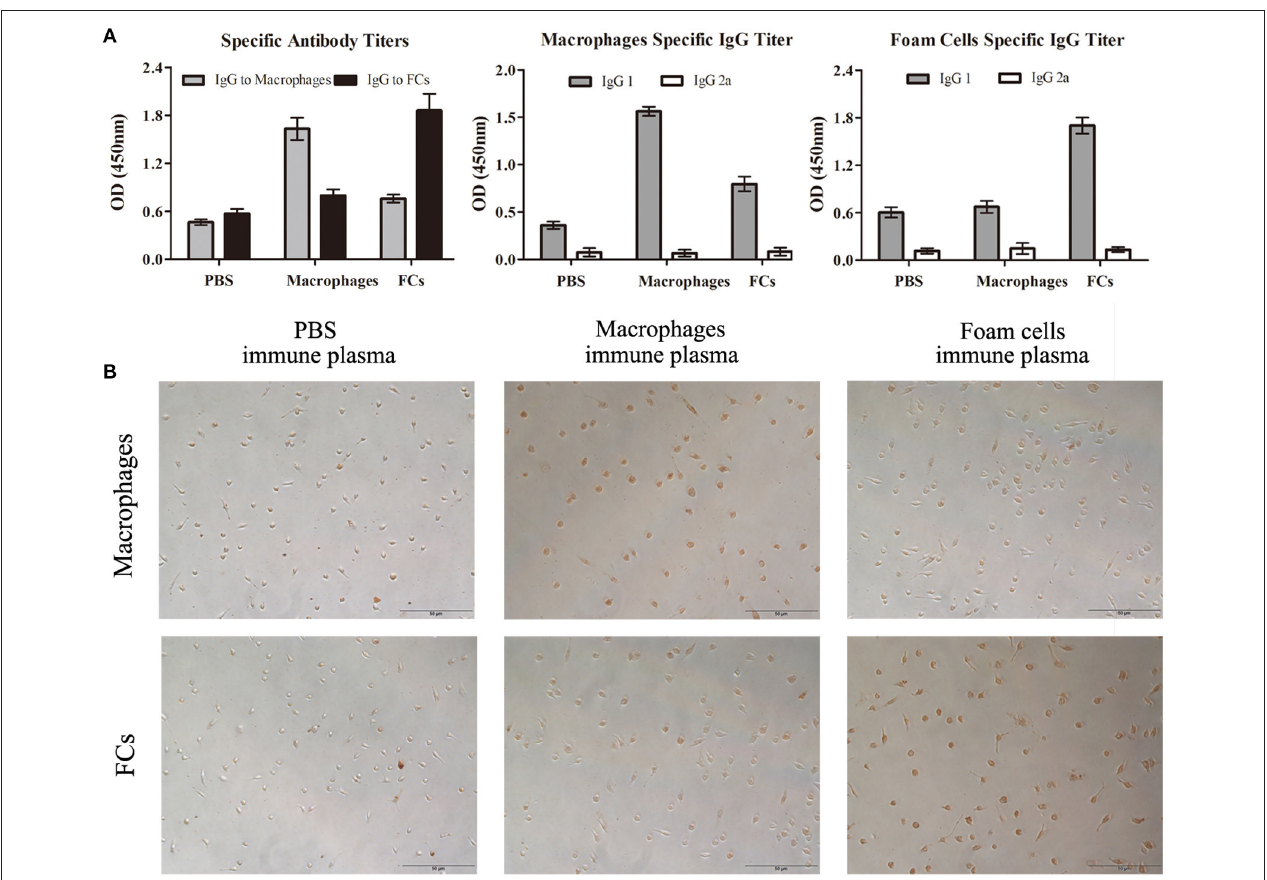
FIGURE 5 | FCs immunization results in a specific antibody response in initial atherosclerosis. (A) ELISA was performed to measure the specific antibodies to FCs and macrophages as well as immunoglobulin isotypes including IgG1 and IgG2a titers. Data are shown at plasma dilutions of 1: 800 for each group ( n = 8). OD, optical density. (B) Peritoneal macrophages and FCs were fixed and stained with PBS-immune, Macrophages-immune or FCs-immune plasma (dilution 1:50). Scale bars, 50 µ